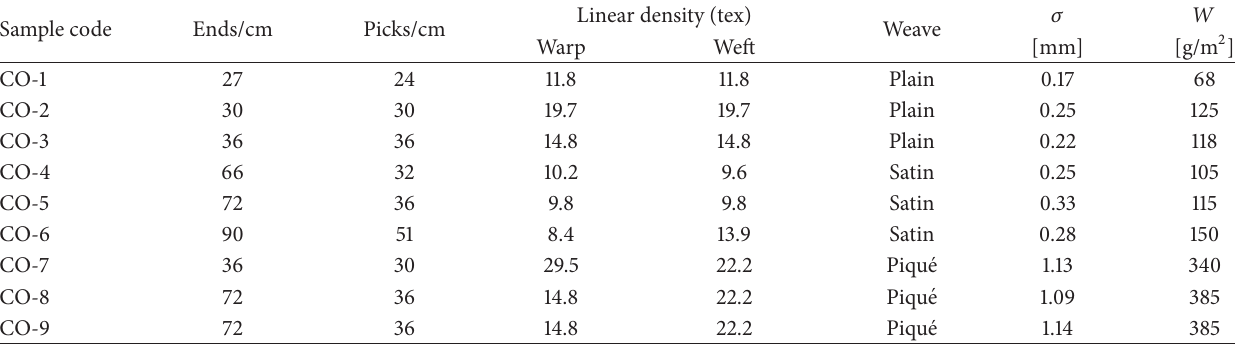
Table 1: CO samples structural